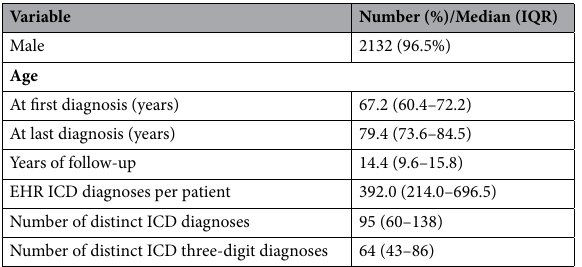
Table 1. Patient characteristics (n = 2210). EHR Electronic health record, ICD International Classification of Diseases (ninth edition). *Among 3,121 patients included in CSP #380, 2,787 had available data with 2,210 having 5-year